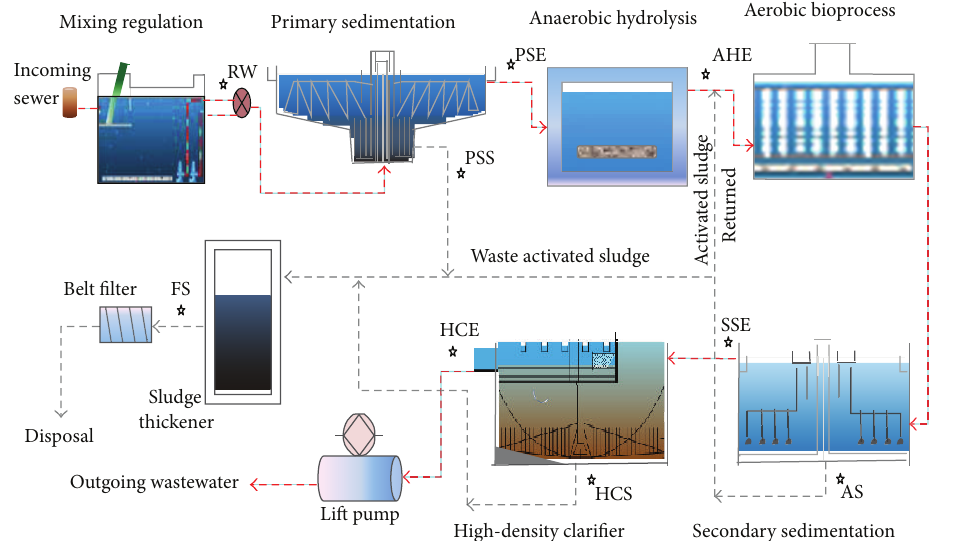
Figure 1: Flow chart of the centralized WWTP in Zhejiang, China ( f : location of samplings). RW, raw wastewater; PSE, primary sedimentation effluent; AHE, anaerobic hydrolysis effluent; SSE, secondary sedimentation effluent; HCE, high-density clarifier effluent; PSS, primary sedimentation sludge; AS, activated sludge; HCS, high-density clarifier sludge; and FS, final